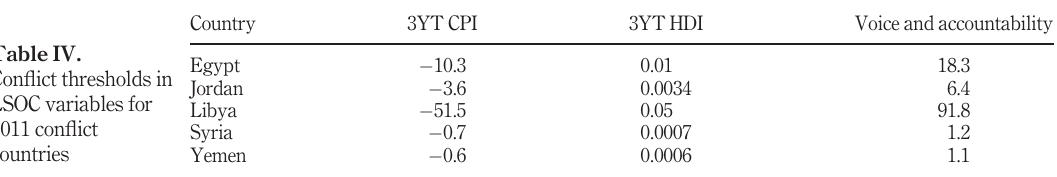
Table IV. Con fl ict thresholds in LSOC variables for 2011 con fl